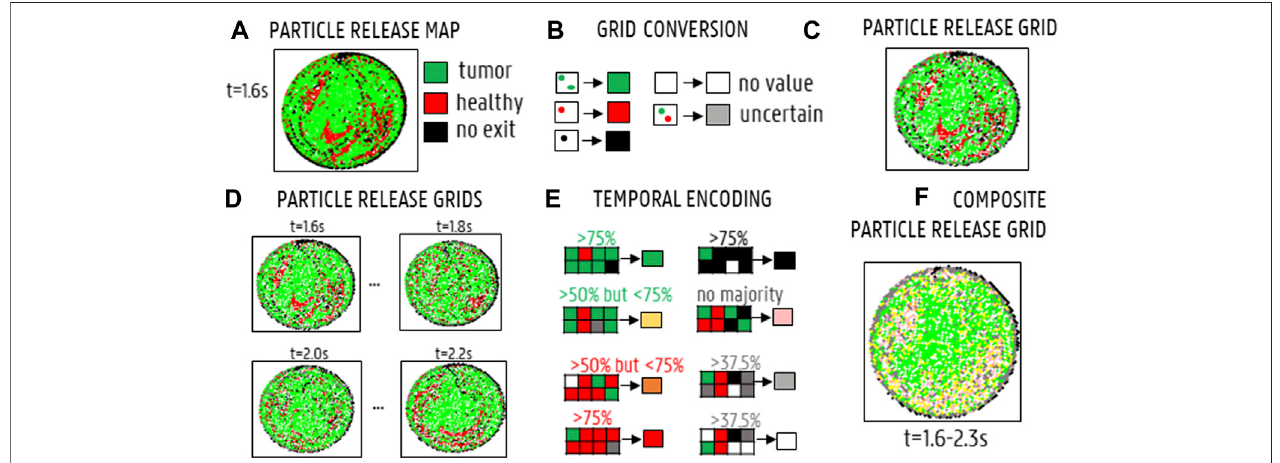
FIGURE5| GeneratingCompositeParticleReleaseGrids(CPRGs): (A) ParticleReleaseMapsshowtherelationbetweeninjectionlocationandparticlefate(green: tumor, black: no exit, red: healthy, grey: spatially uncertain, white: no value). (B) By de fi ning areference grid and assigning each grid cell a color according to the particle fate of the injection positions within that cell, a Particle Release Grid (PRG) is obtained. (C) PRG for injection at the start of the cycle ( “ 1.6s ” ). (D) PRGs visualized for four injectiontimings( “ 1.6s ” , “ 1.8s ” , “ 2.0s ” , “ 2.2s ′ ” ). (E) BycomparingPRGcellvaluesfordifferentinjectiontimings,aCPRGisgenerated(green: “ tumor ” for > 75%ofthe timings, red: “ healthy ” for > 75% of the timings, yellow: “ tumor ” > 50%, orange: “ healthy ” > 50%, black: > 75% “ no exit ” , pink: no majority fate found, grey: > 37.5% “ uncertain ” , white: > 37.5% “ no value ” ). (F) CPRG generated for the full cycle, based on 8 injection timings (1.6 – 2.3 s, with a spacing of 0.1